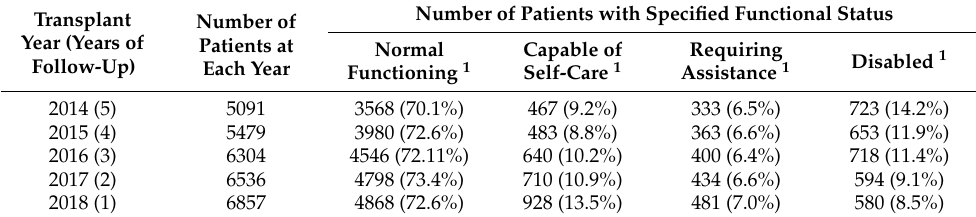
Table 3. Functional status in study patients by the year of